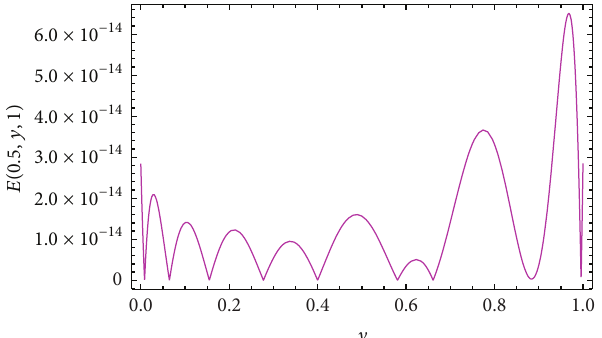
Figure 5: Space graph of numerical solution of problem (46) at ] 1 = = 1.5 and 𝑁 = 𝑀 = 10 . ] 2